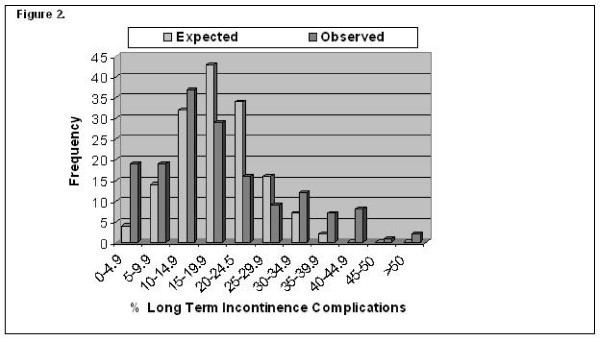
Histograms juxtapose observed and expected number of surgeons' long-term incontinence. More outliers on right side of histogram in observed vs. expected plot highlight providers achieving poor outcomes. On the contrary, outliers toward left in observed vs. expected plots indicate surgeons achieving more favorable outcomes (From Bianco, J Urol, 2005, copyright permission).